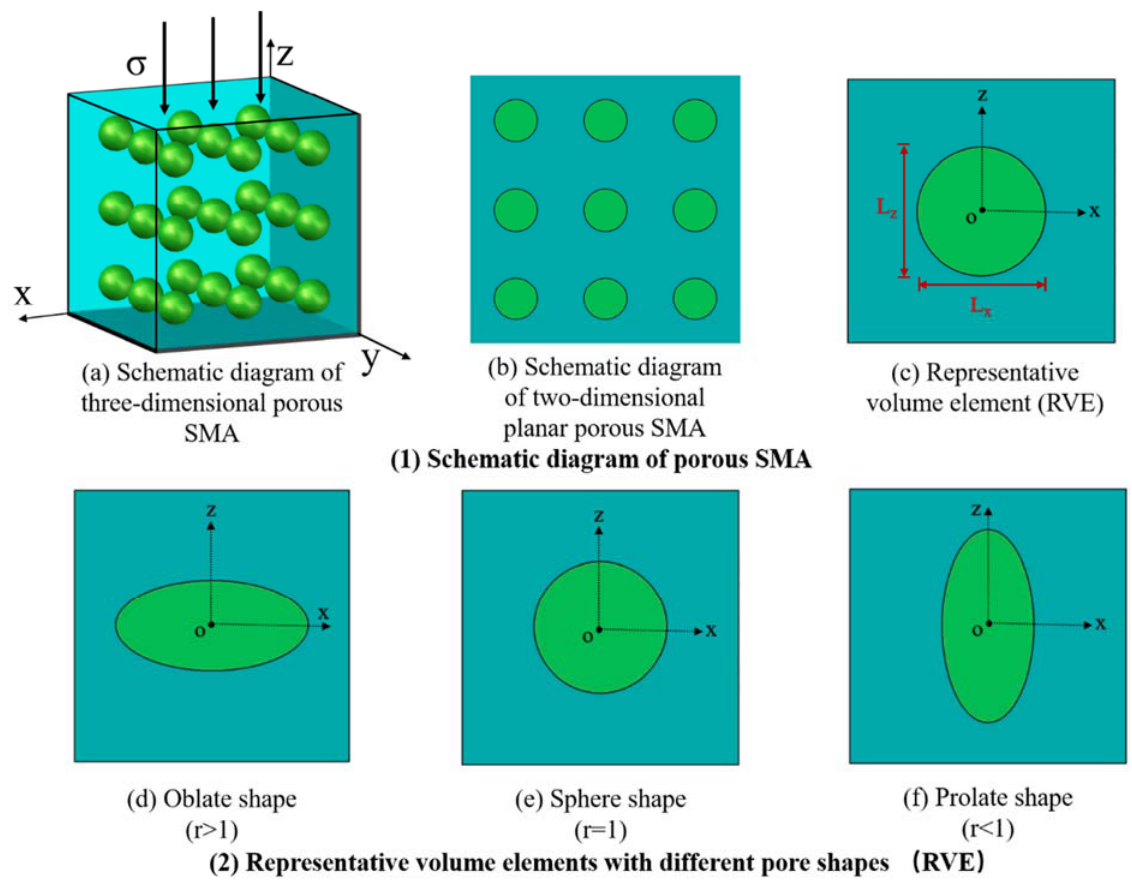
Figure 1. Schematic diagram of the pore shape.